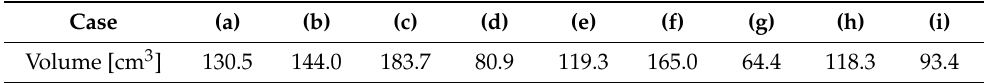
Table 3. The volume of models in [cm 3 ].